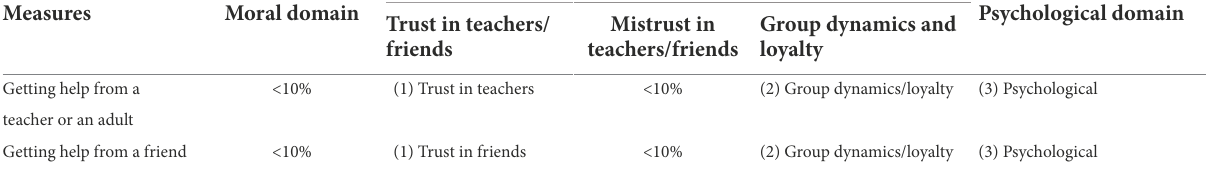
TABLE 3 Categories used in reasoning